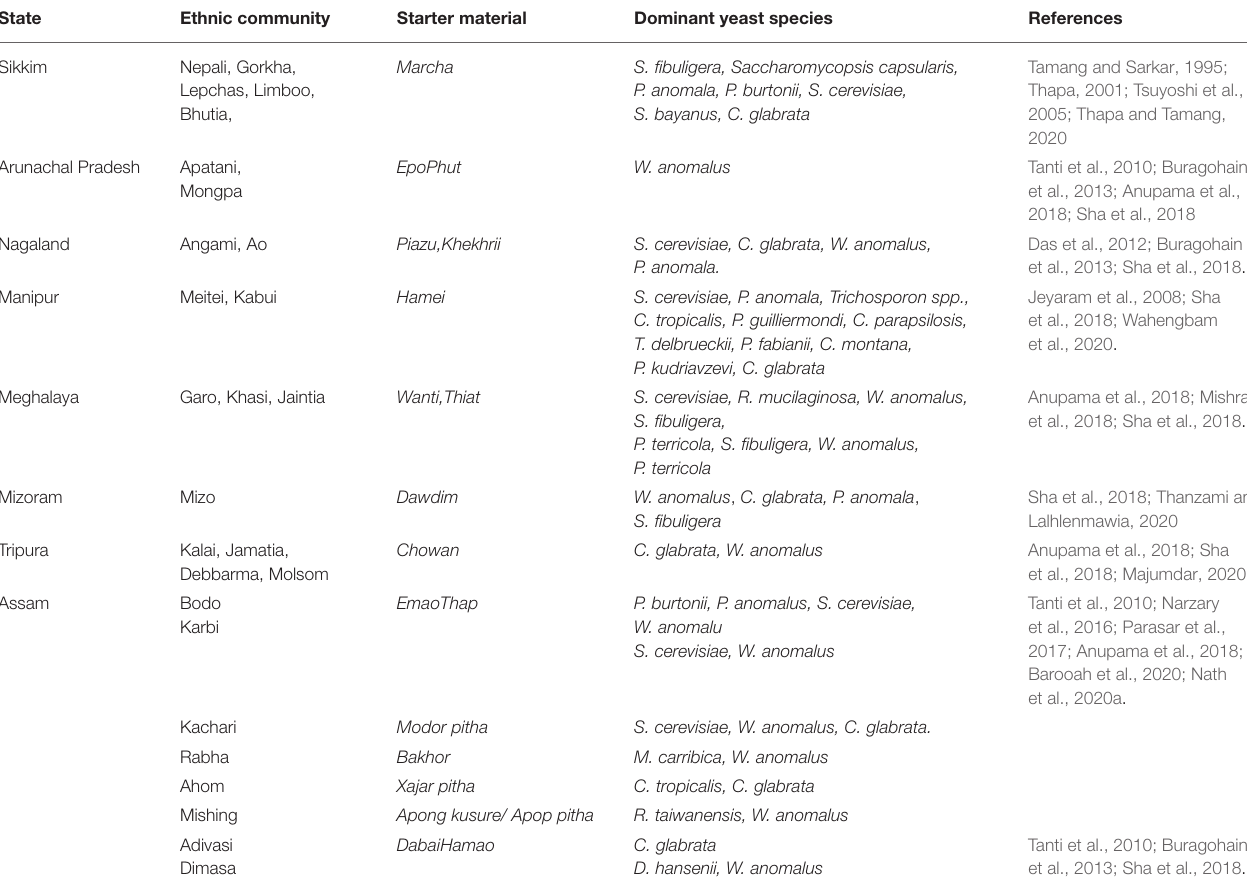
TABLE 1 | Dominant yeast species associated with starter materials from ethnic communities of northeast India.